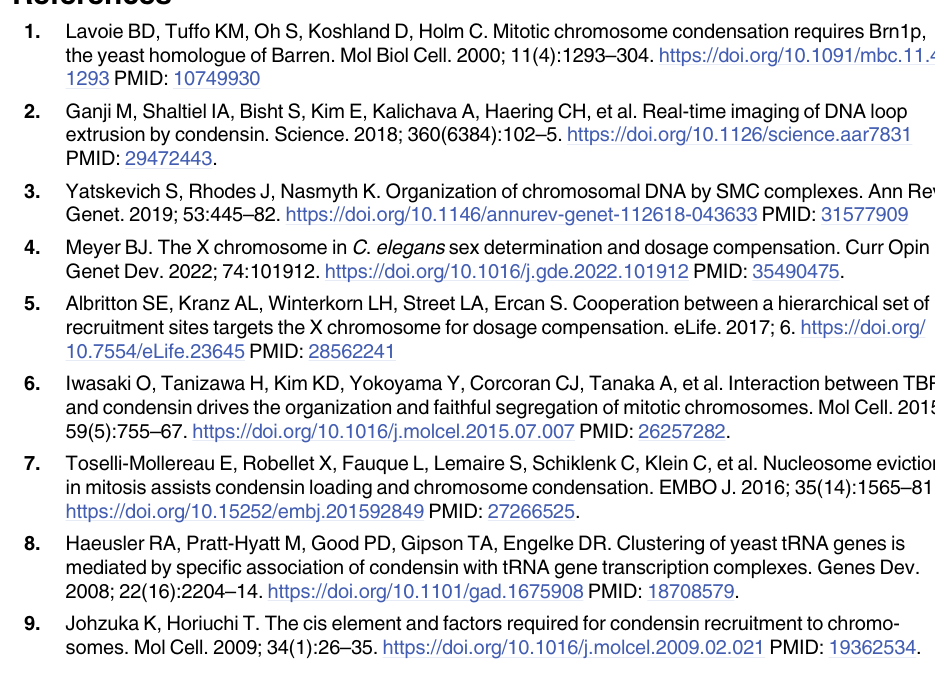
S3 Table. List of oligonucleotides used in the study.